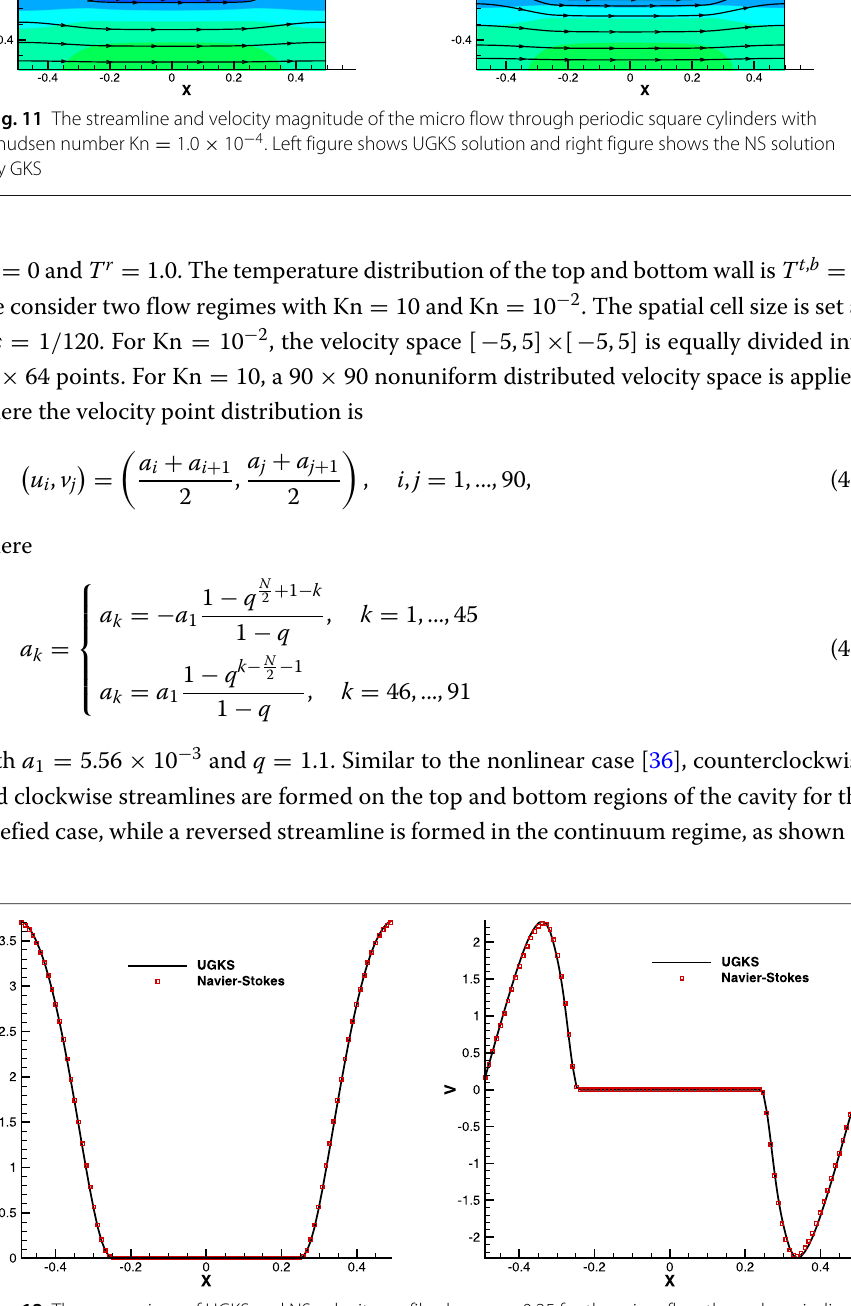
Fig. 12 The comparison of UGKS and NS velocity profile along y = 0.25 for the micro flow through periodic square